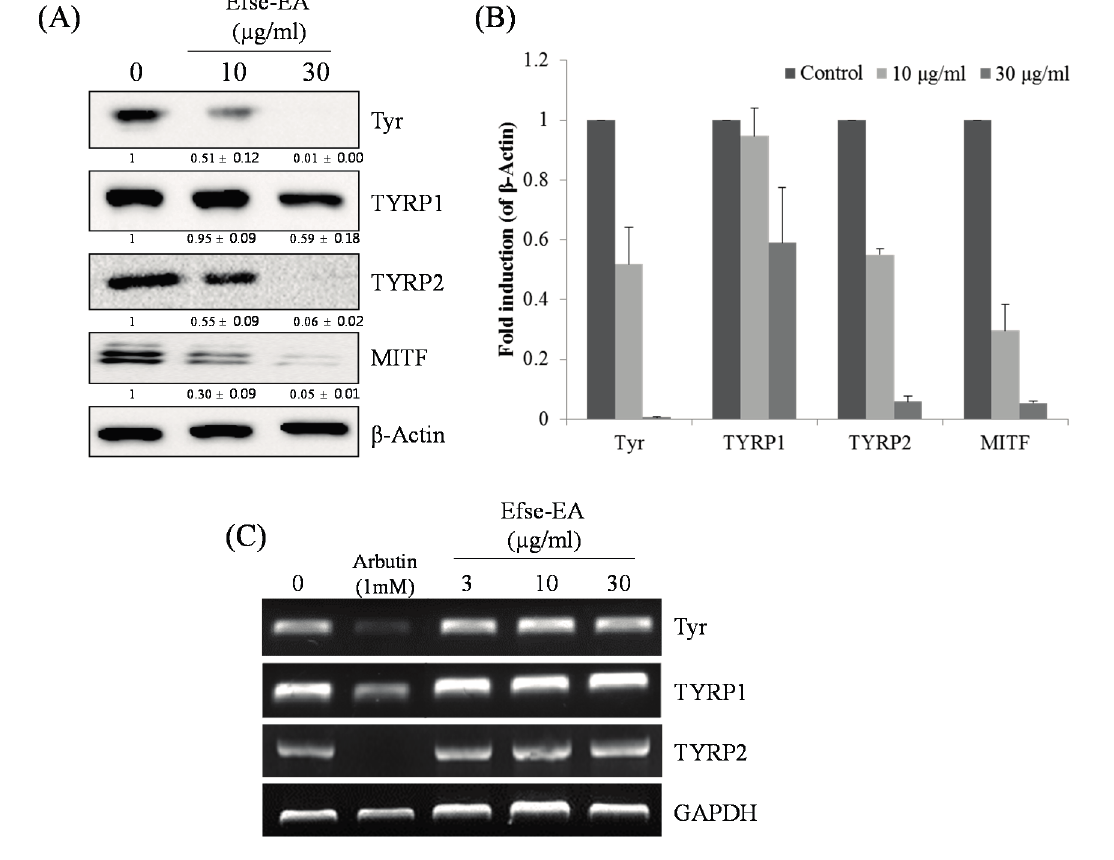
Figure 5. Effect of Efse-EA on the levels of melanogenesis-related mRNA and proteins in melan-a cells. Cells (1 × 10 5 cells/mL) were cultured for 24 h; the medium was replaced with fresh medium containing the indicated concentrations of Efse-EA or arbutin for three days. Total cell lysates were extracted and assayed by Western blotting using antibodies against tyrosinase, tyrosinase-related protein (TYRP)-1, TYRP-2, and microphthalmia-associated transcription factor (MITF). Equal amounts of protein loading were confirmed using β -actin ( A ); Relative intensity of melanogenesis-related protein expressions, the intensity of the protein expressions was compared to the control; The normalized data for each were plotted as bar graphs ( B ); Cells (1 × 10 5 cells/mL) were cultured for 24 h; the medium was replaced with fresh medium containing the indicated concentrations of Efse-EA or arbutin for 1 day. The mRNA was extracted using TRIzol; mRNA expression was analyzed by reverse-transcription polymerase chain reaction ( C